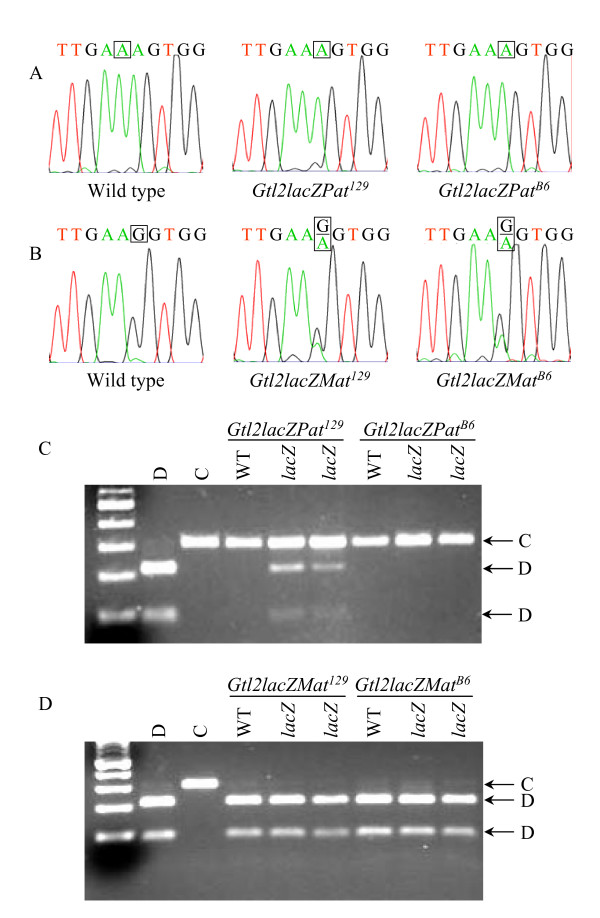
Dlk1-Gtl2 imprinting analysis in Gtl2lacZ embryos. A) Imprinting assay for Dlk1 in wild type (left), Gtl2lacZPat129 (center) and Gtl2lacZPatB6 (right) embryos. B) Imprinting assay for Dlk1 in wild type (left), Gtl2lacZMat129 (center) and Gtl2lacZMatB6 (right) embryos. The Dlk1 polymorphism is an "A" in D embryos and a "G" in C embryos; the polymorphic base is boxed on each chromatogram. C) Imprinting assay for Gtl2 in Gtl2lacZPat129 and Gtl2lacZPatB6 embryos. D) Imprinting assay for Gtl2 in Gtl2lacZMat129 and Gtl2lacZMatB6 embryos. The Gtl2 polymorphism alters an SfcI restriction enzyme site, with the site present in D and absent in C; the D and C bands are indicated at the right.